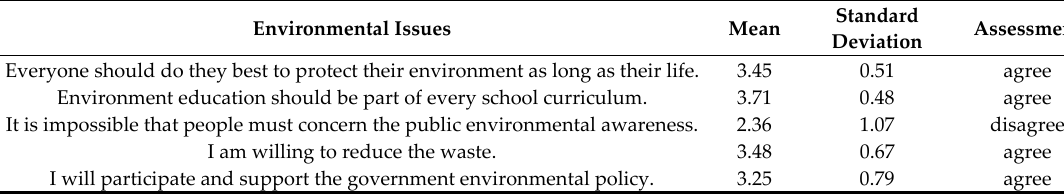
Table 3. Mean and standard deviation of students’ attitude.